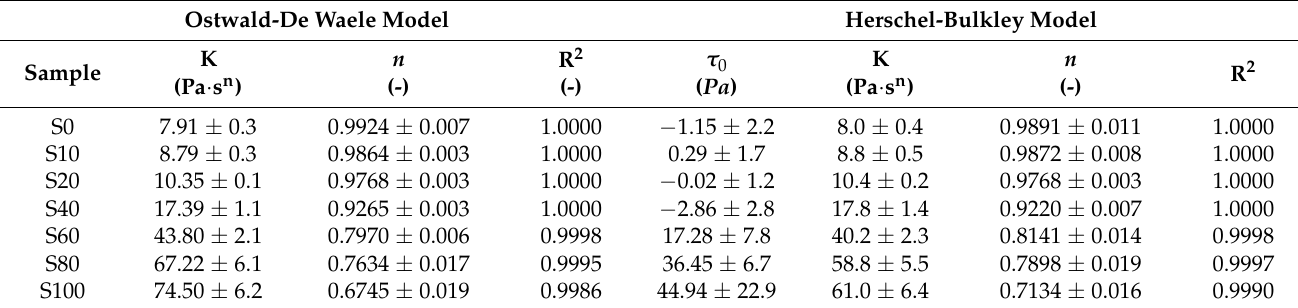
Table 3. Resulting parameters of the rheological